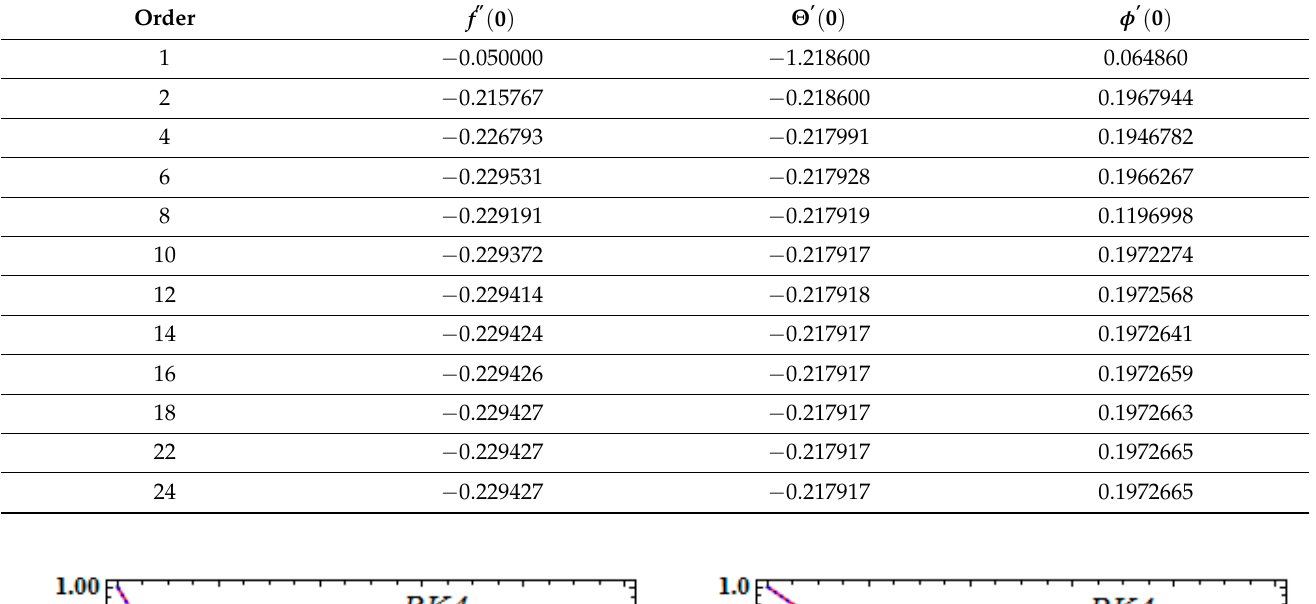
Table 1. Twenty-fourth-order approximation for RK4 convergence, where λ 1 = Sc = 0.4, Nt = Gr = b = St = 0.2, and Pr = Nb = Gm = 0.2.